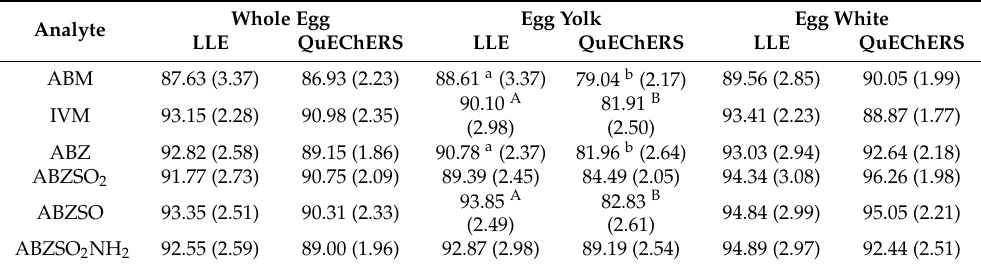
Table 1. Comparison of recoveries obtained from LLE and QuEChERS